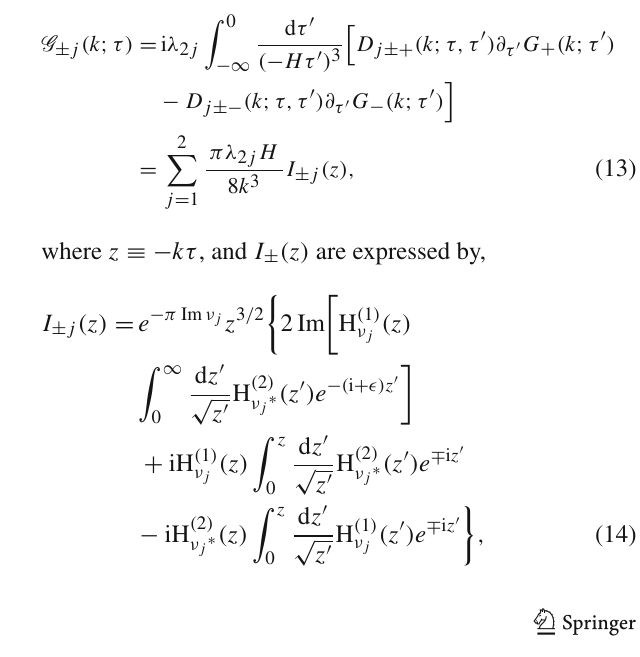
Fig. 4 In the left hand side of this diagram the red backslash filled circle indicates on both types of + and − propagators of massless field δφ for two point function (cid:6) δσ 2 δφ (cid:7) ; they are presented in the right hand side respectively by the red filled and white empty